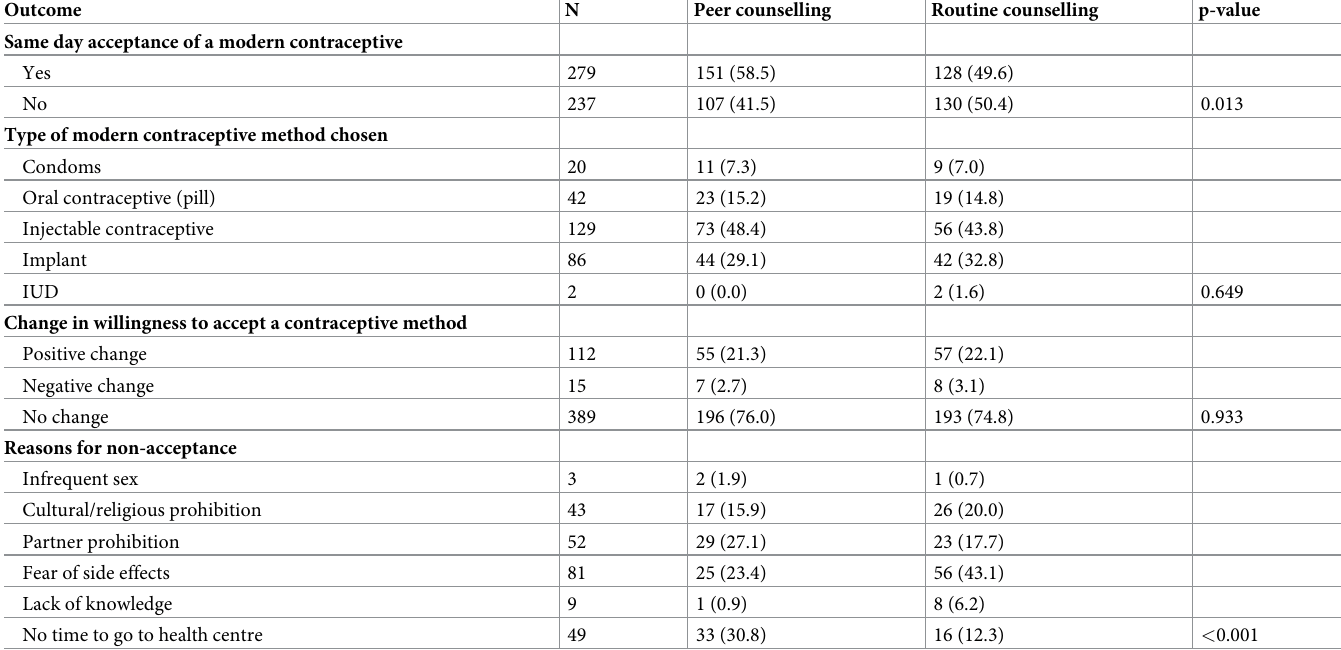
Variables associated with same day acceptance at bivariate analysis were study group, ethnicity, occupation, marital status, partner’s age, partner’s education and partner’s occupation, and Table 2. Primary and secondary outcomes by study group. Outcome